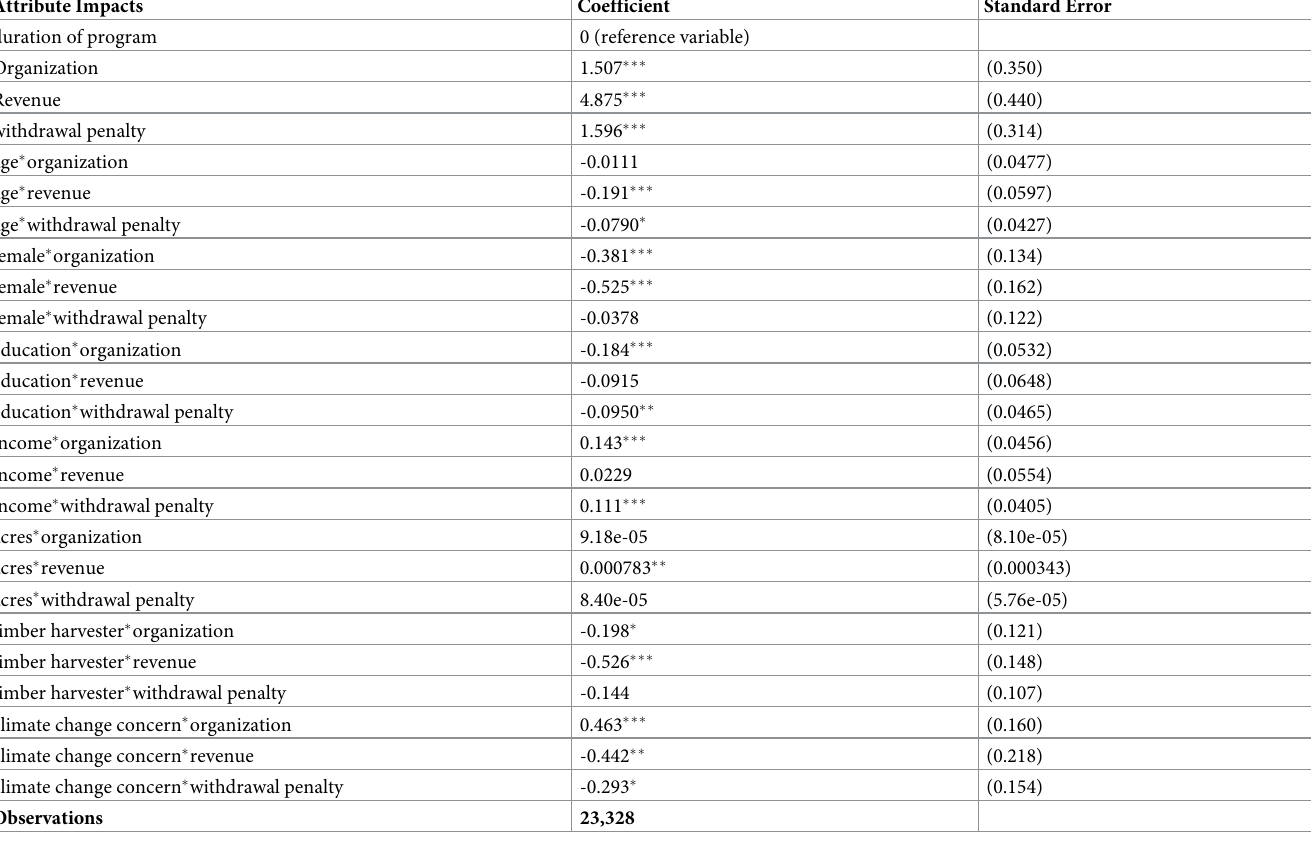
Table 5. Conditional logit attribute